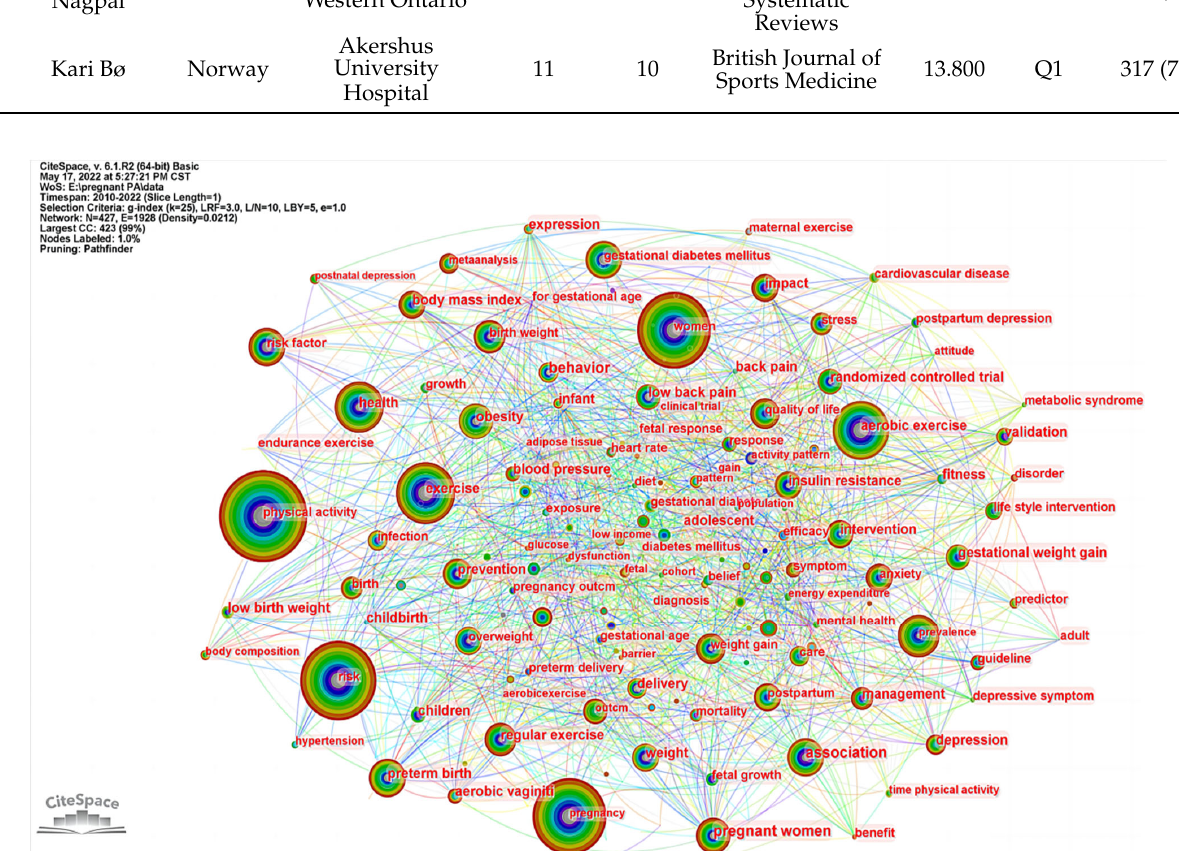
Figure 7. Co ‐ occurrence map of keywords in research of physical activity during pregnancy. Figure 7. Co-occurrence map of keywords in research of physical activity during The largest nine clusters based on the co ‐ occurrence map of keywords were obtained in the form of cluster view (Figure 8) and timeline view (Figure 9) respectively. The time ‐ line view map demonstrates time points of appearance and corresponding duration time of each cluster with nodes and arcs on a horizontal time axis. The size of nodes represents the number of publications while the length of the arcs reflects the duration time. Figure 8. Cluster map of keywords in research on physical activity during pregnancy.